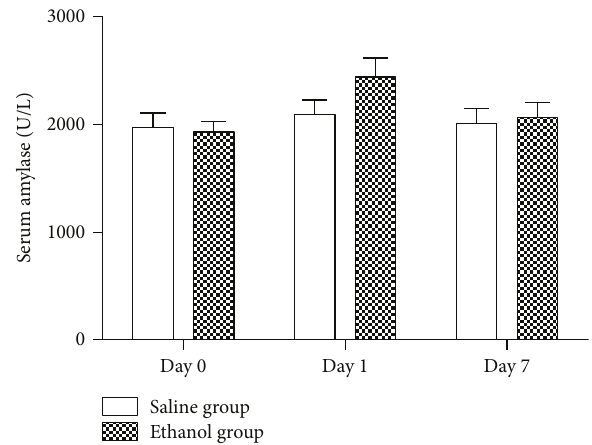
Figure 6: Change in serum amylase levels after ethanol injection into the orthotopic pancreatic cancer cell mouse xenografts. Blood samples were collected from the mouse-tail vein on days 0, 1, and 7 after ethanol injection and then assessed for serum amylase levels.